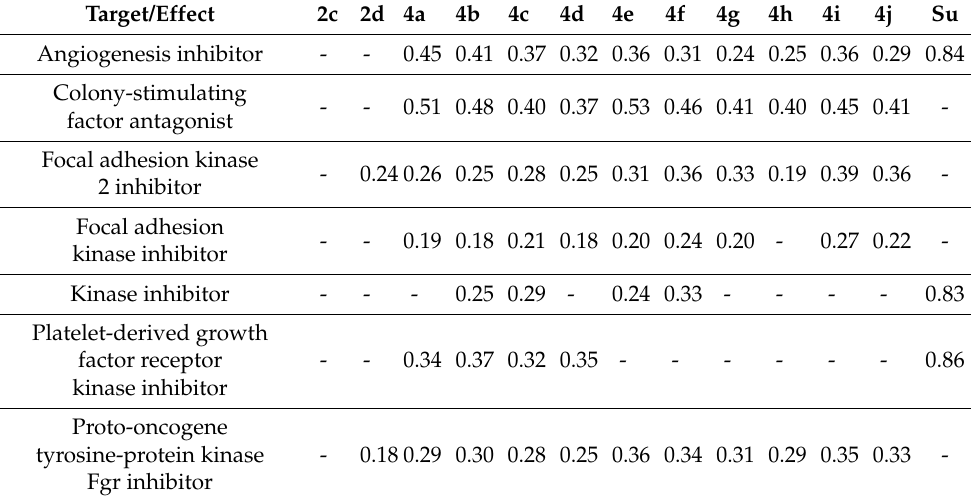
Table 3. The PASS predicted probabilities of the new pyrrole derivatives to be active (Pa) towards oncological proteins. Sunitinib (Su) was used as a